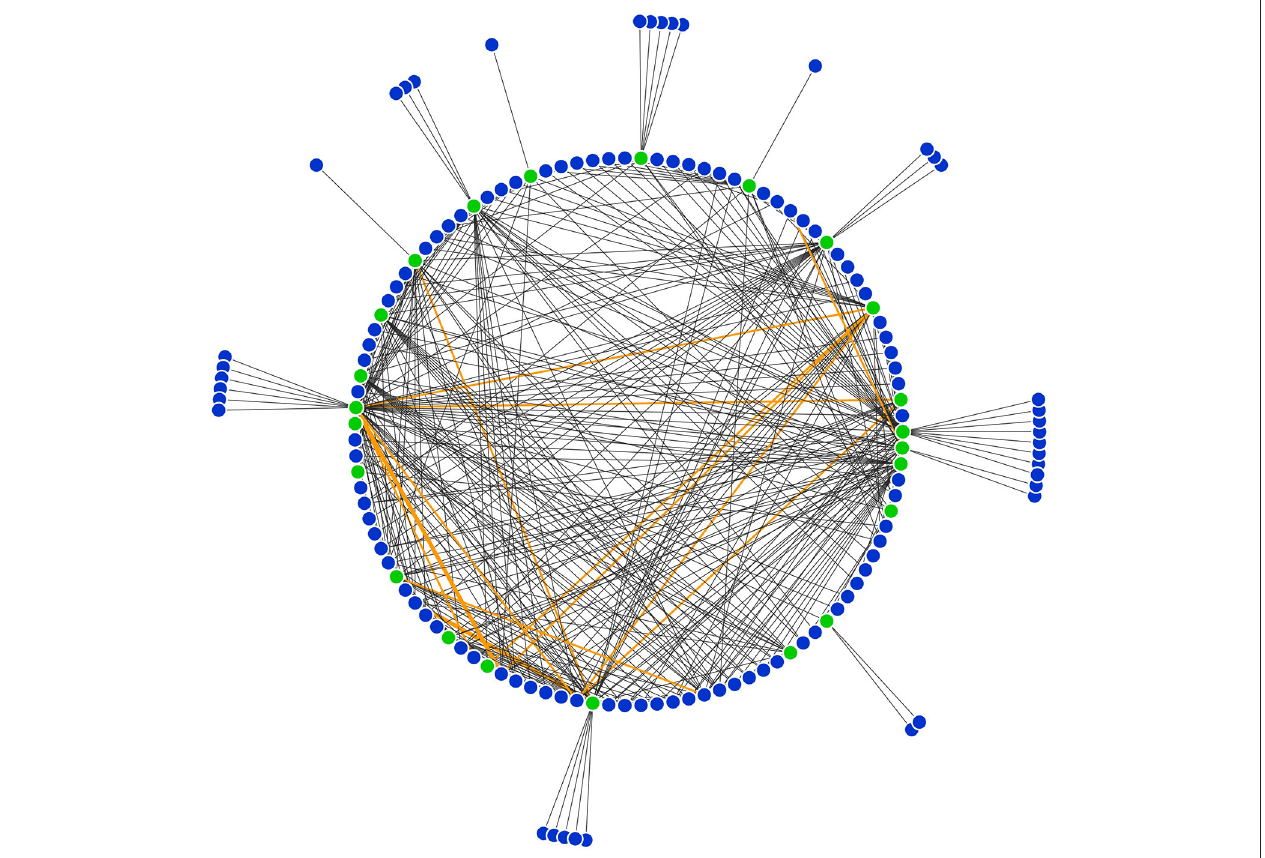
FIGURE 2 | Network of how the cubs are connected to other individuals (excluding adult-adult connections) over nine nights, i.e., a period-wide network of all 144 observed individuals. Cubs are represented by green dots, adults by blue dots. Orange lines indicate that the pair was seen together more than once, the thicker the orange line the more shared occurrences the pair